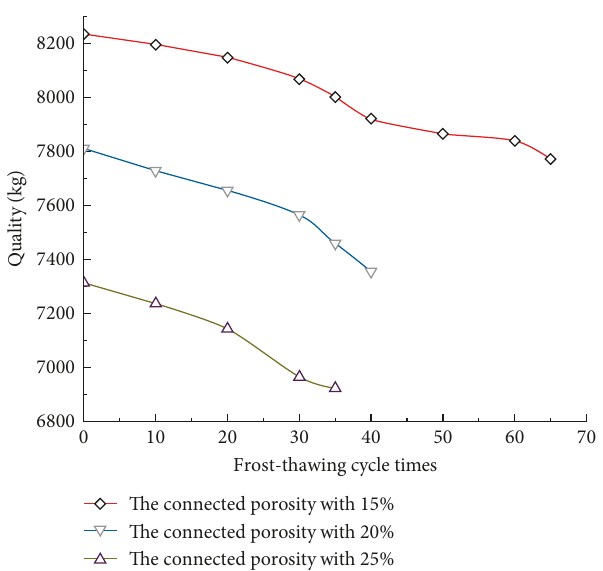
Figure 13: Relationship between quality and maximum frost- thawing cycle times.